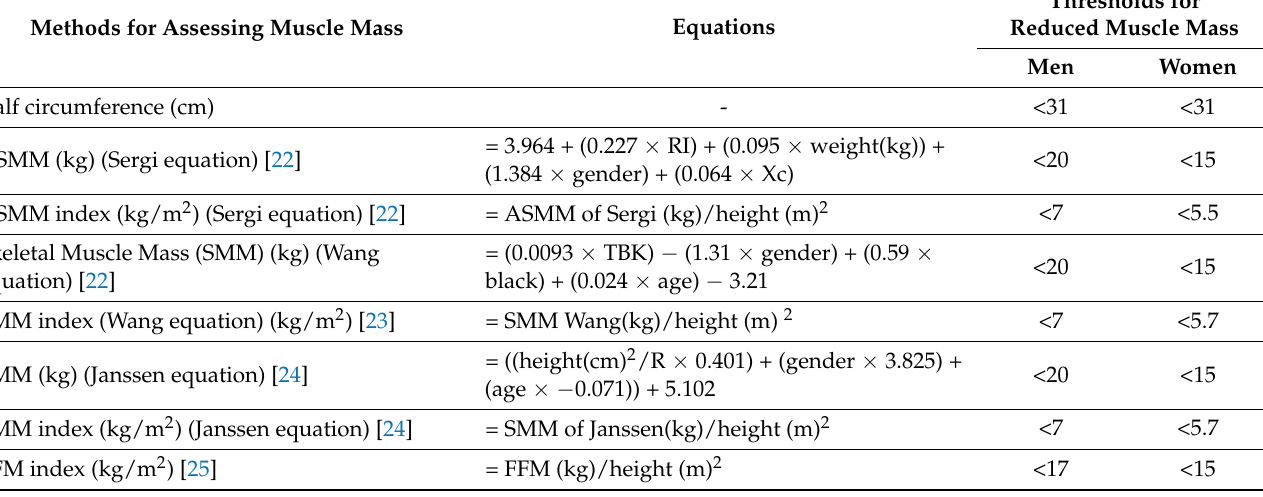
Table 1. Methods for muscle mass assessment and thresholds used for determining reduced muscle mass according to the Global Leadership Initiative on Malnutrition [9]